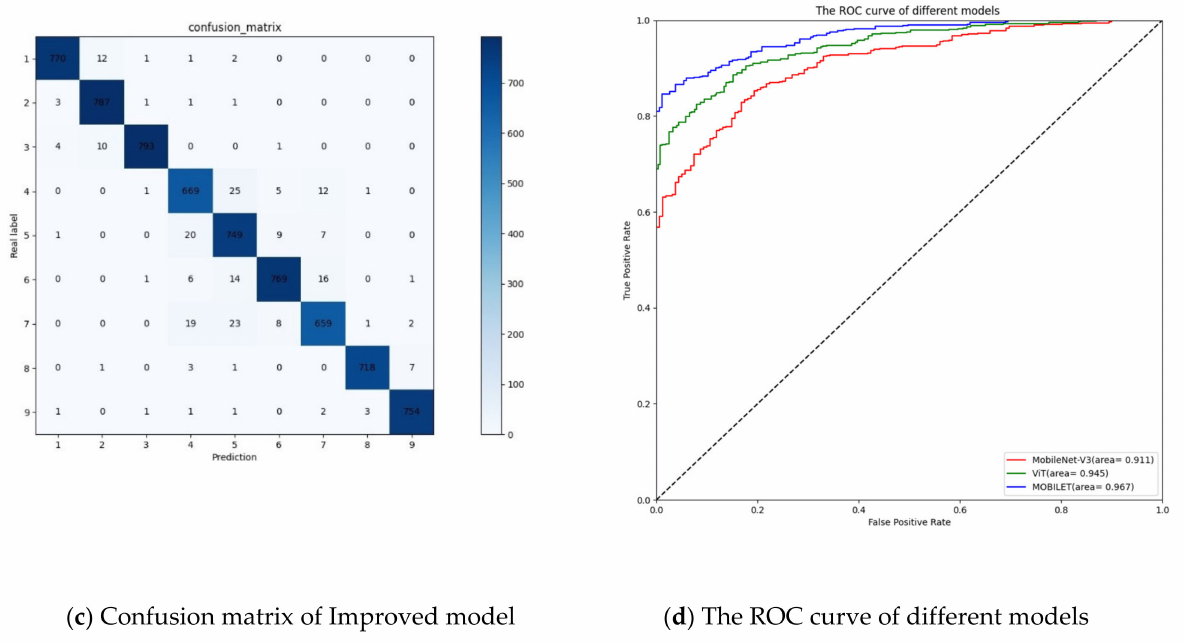
Figure 12. Confusion matrix and ROC curve obtained on Dataset1, where 1:9 in the confusion matrix represents Apple—healthy, rust, scab; Cassava—bacterial blight, brown streak, healthy, mosaic virus; Cotton boll—blight, healthy.